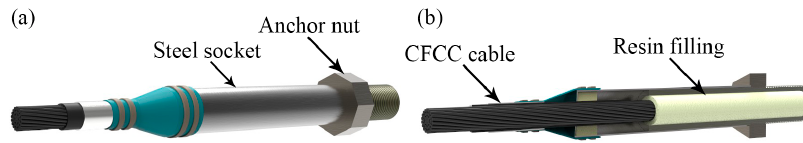
Figure 14. Resin Filling Anchorage, ( a ) full view and ( b ) transparent view.